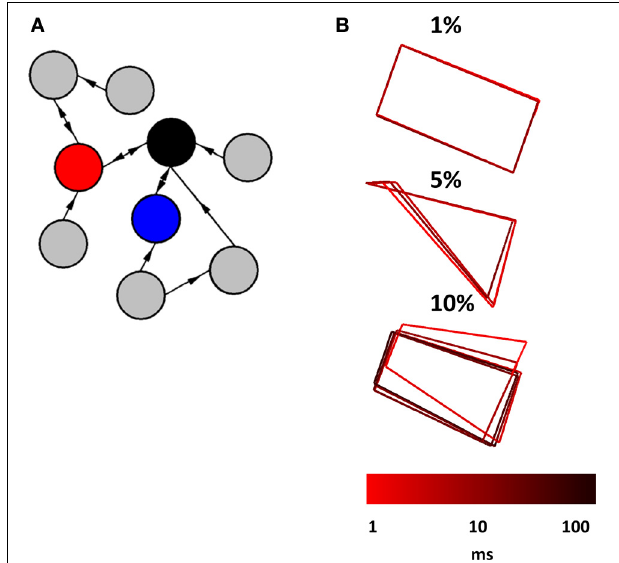
FIGURE 7 | Relay network embedded in a broader network of randomly interconnected nodes. (A) Cartoon illustration of a relay network (red, blue, and black nodes) embedded in a larger network that has random connectivity (gray nodes). The actual network that we simulated had a total of 1000 nodes (not counting those of the relay network itself). (B) Phase-plane plots showing the activity of a relay network. This activity is characteristic of a limit cycle where perturbations from ongoing activity in the surrounding network provide slight alterations to the trajectory. Three plots show patterns of activity obtained from different probabilities of connection between nodes in the surrounding network (1, 5, and 10%). Each run of the model lasted 100s at a resolution of